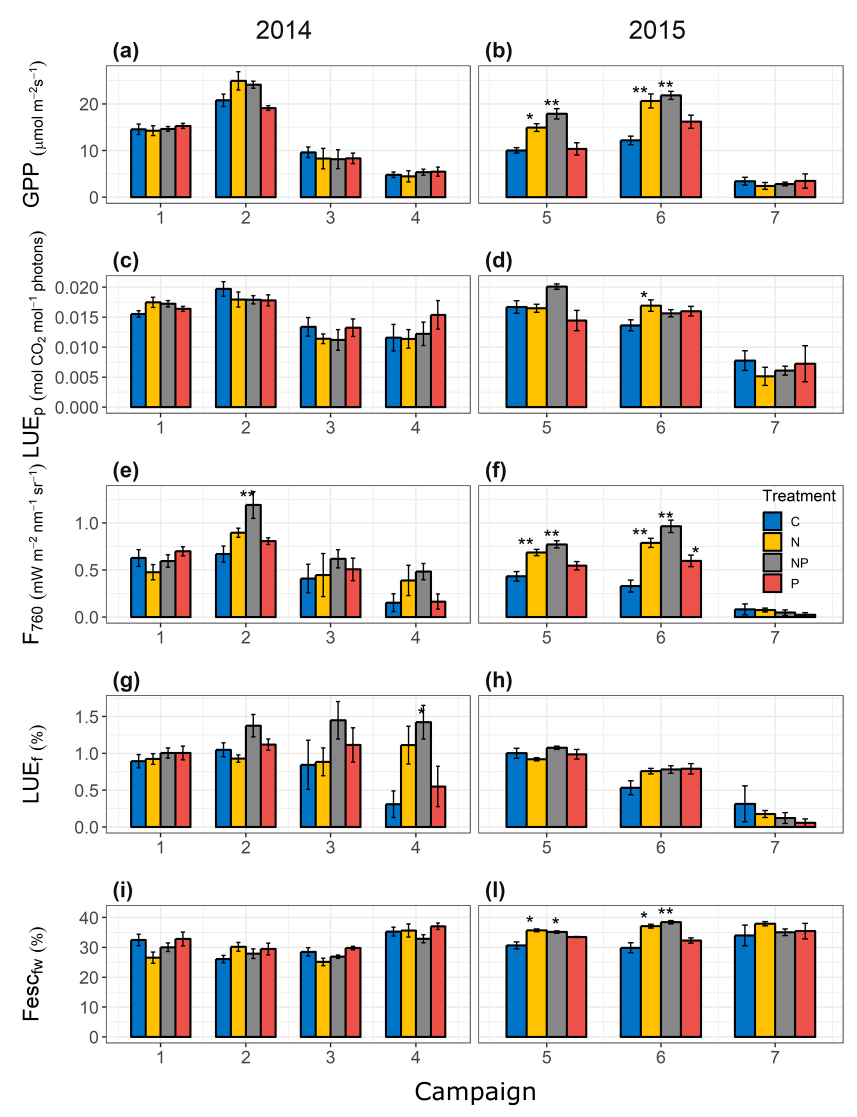
Figure 2. Bar graphs representing di ff erences among treatments (control treatment, C; nitrogen treatment, N; nitrogen and phosphorus treatment, NP; and control treatment, C) of Gross Primary Production (GPP) in 2014 ( a ) and 2015 ( b ); light use e ffi ciency of photosynthesis (LUE p ) in 2014 ( c ) and 2015 ( d ); Fluorescence at 760 nm (F 760 ) in 2014 ( e ) and 2015 ( f ); light use e ffi ciency of fluorescence emission at 760 nm (LUE f ) in 2014 ( g ) and 2015 ( h ); and fraction of F 760 that escapes the canopy (Fesc fw ) in 2014 ( i ) and 2015 ( l ). Data are divided among campaigns. Bar graphs represent means and error bars represent 1 standard error. Group di ff erences in ( a – h ) were analyzed with ANOVA test and individual di ff erences among groups were evaluated with Tukey HSD post hoc test. Group di ff erences in ( i , l ) were analyzed with ANOVA with the Welch correction and individual di ff erences among groups were evaluated with the Games–Howell post hoc test. “*” refers to a significant di ff erence from the control treatment with p value < 0.05 and “**” refers to a significant di ff erence from the control treatment with p value <